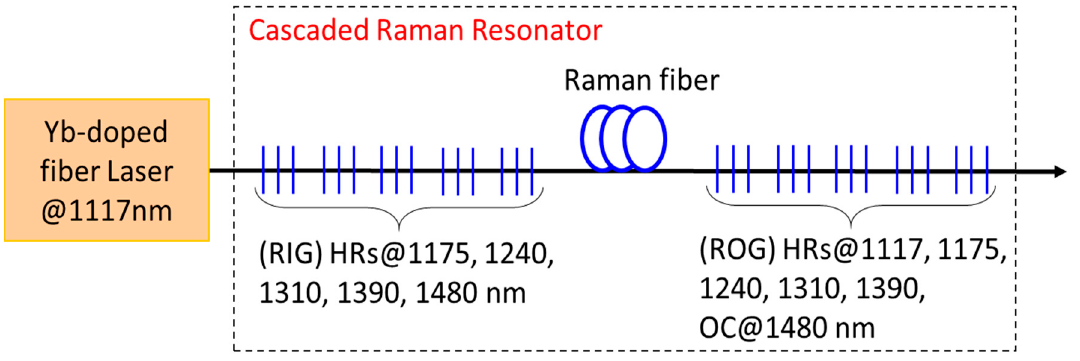
Figure 8. Schematic representation of a Raman fiber laser with multiple wavelength shifts by using a cascaded Raman resonator (RIG—Raman input grating set, ROG—Raman output grating